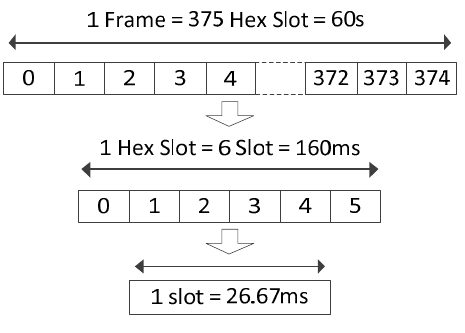
Figure 2. VDE Frame structure.